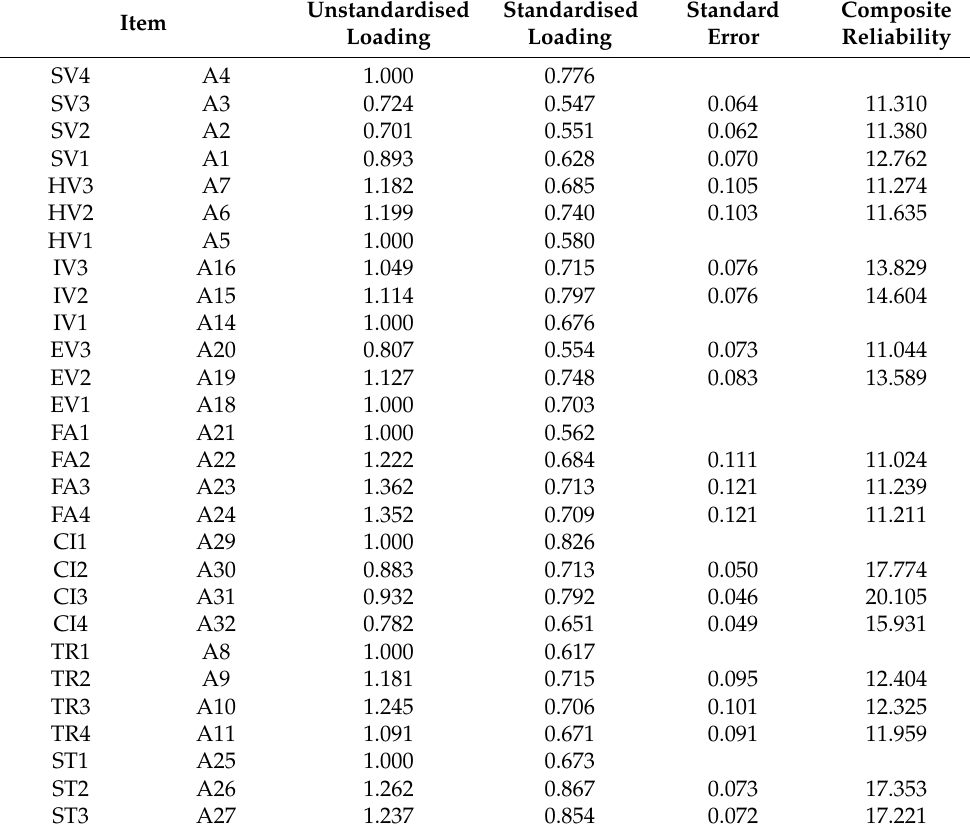
Table 6. Standardised loading, standard error, and composite